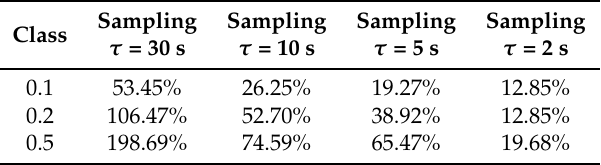
Table 5. Maximal relative error of the line temperature estimation method for an incomplete set of noise-containing